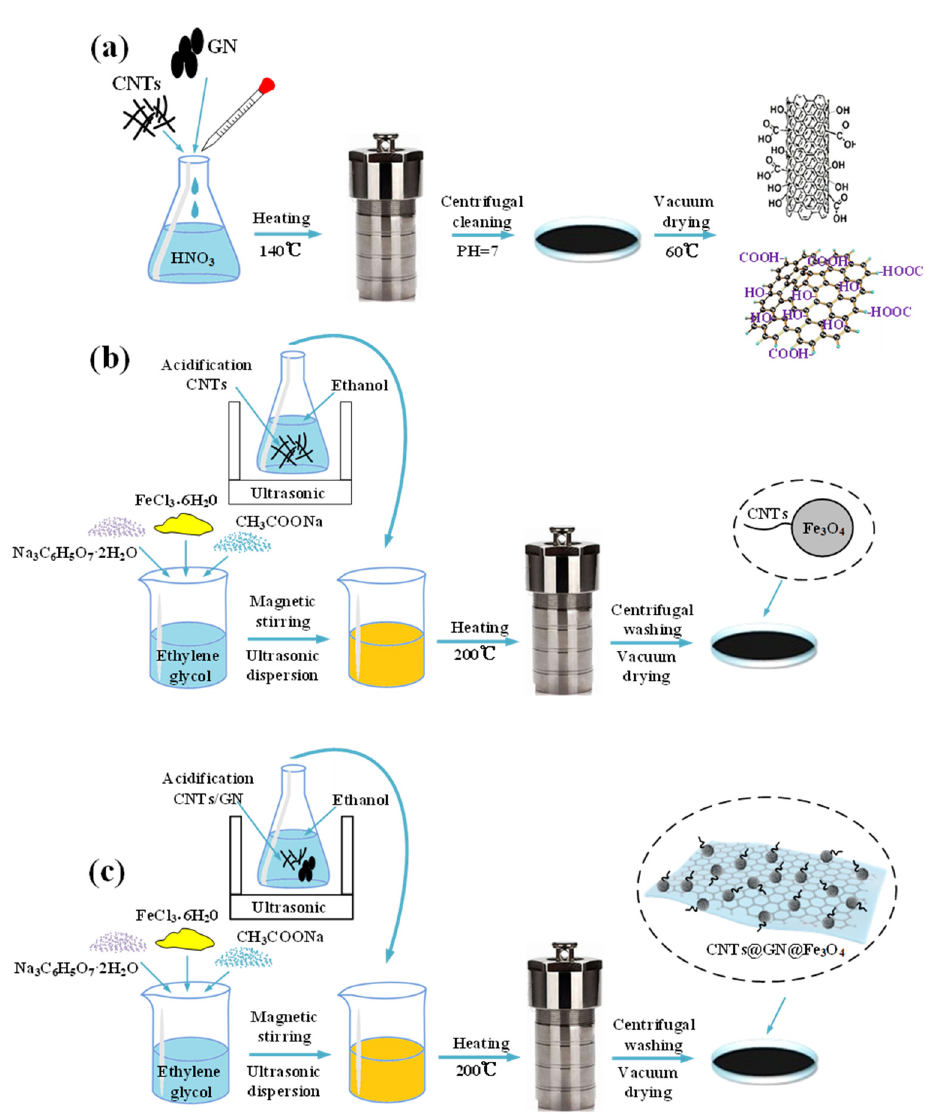
Figure 1. ( a ) Acidification process of CNTs and GN; ( b ) preparation process of CNTs@GN@Fe 3 O 4 particles; ( c ) preparation process of CNTs@GN@Fe 3 O 4 /PU composite material. particles; ( c ) preparation process of CNTs@GN@Fe 3 O 4 /PU composite